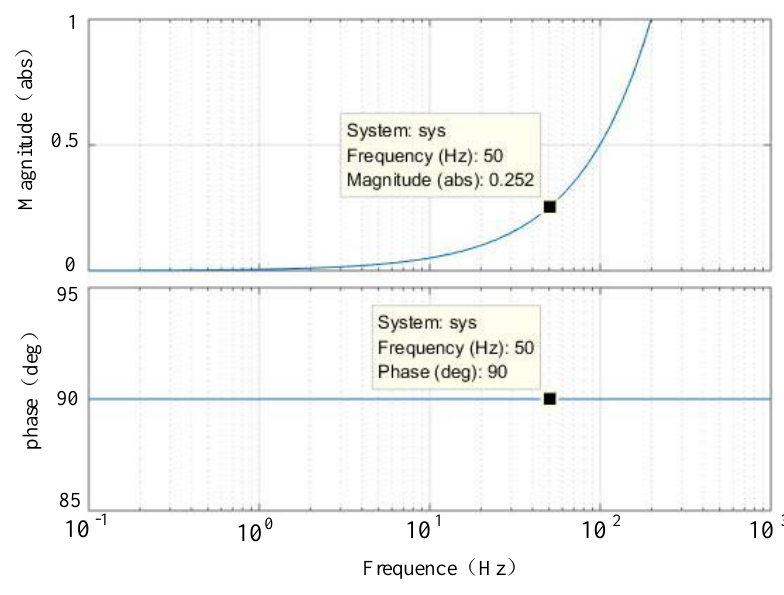
Figure 6. Bode diagram of output impendence.